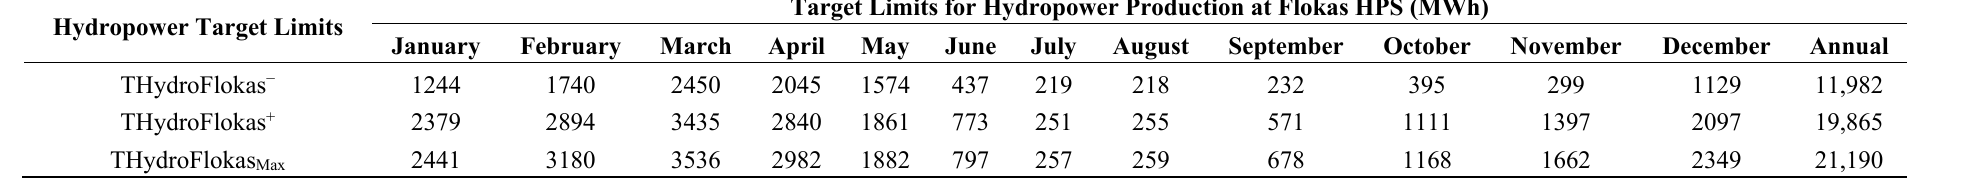
Table 3. Upper (THydroFlokas + ) and lower (THydroFlokas − ) bound of the optimized target for hydropower production and the maximum allowable (THydroFlokas Max ) at the HPS at